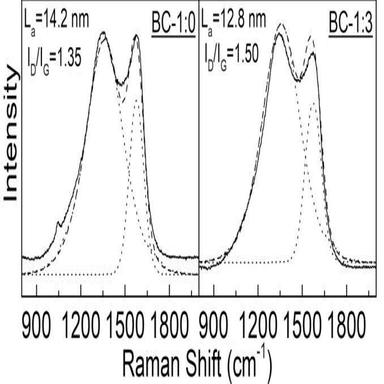
Raman spectra and ID/IG ratio of the intrinsic and nitrogen doped biocarbons.